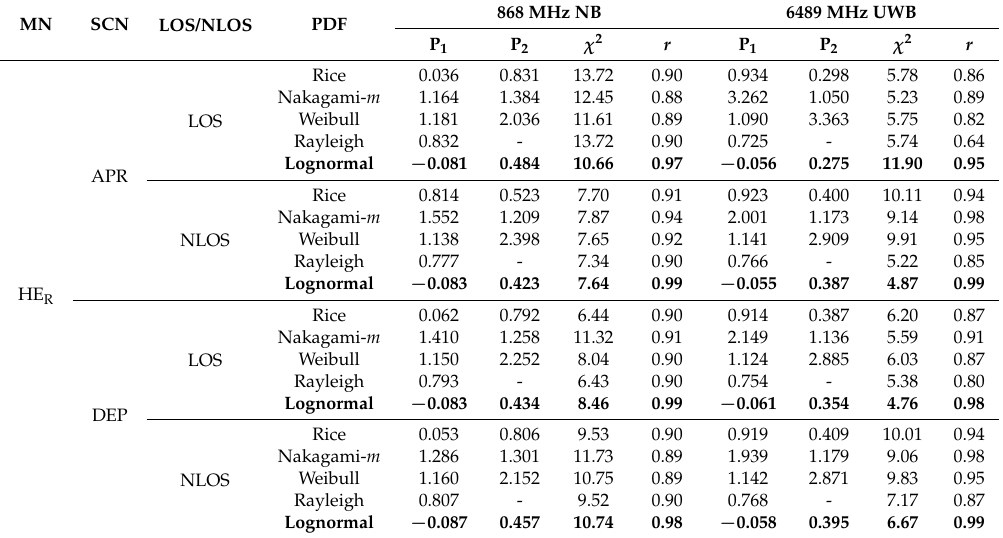
Table 3. The parameters of PDFs fitted to empirical distributions of small-scale fading amplitudes for HE R .